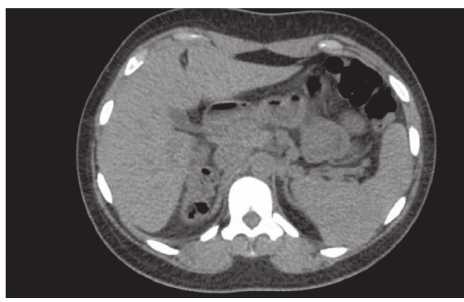
Figure 2: The uncinate process, head and body appear normal in size, but pancreatic tail is not visualized on noncontrast CT scan. Table 1: Pertinent labs done on the patient, showing low mag- nesium and high uric acid